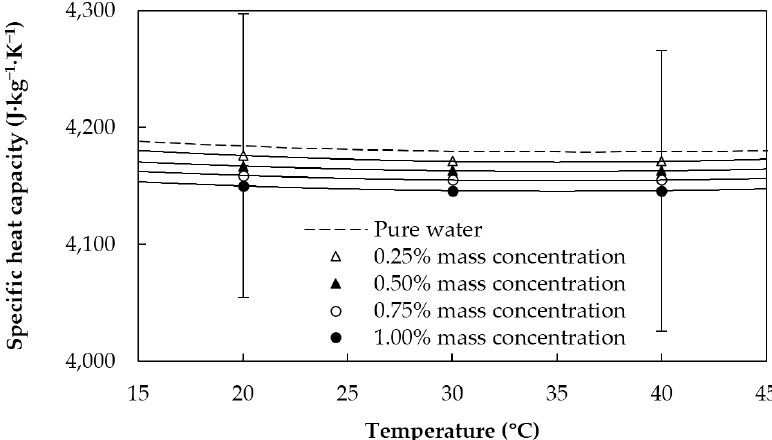
Figure 4. Specific heat capacity of the sulfonic acid-functionalized graphene nanoplatelet water-based nanofluids and water [37].